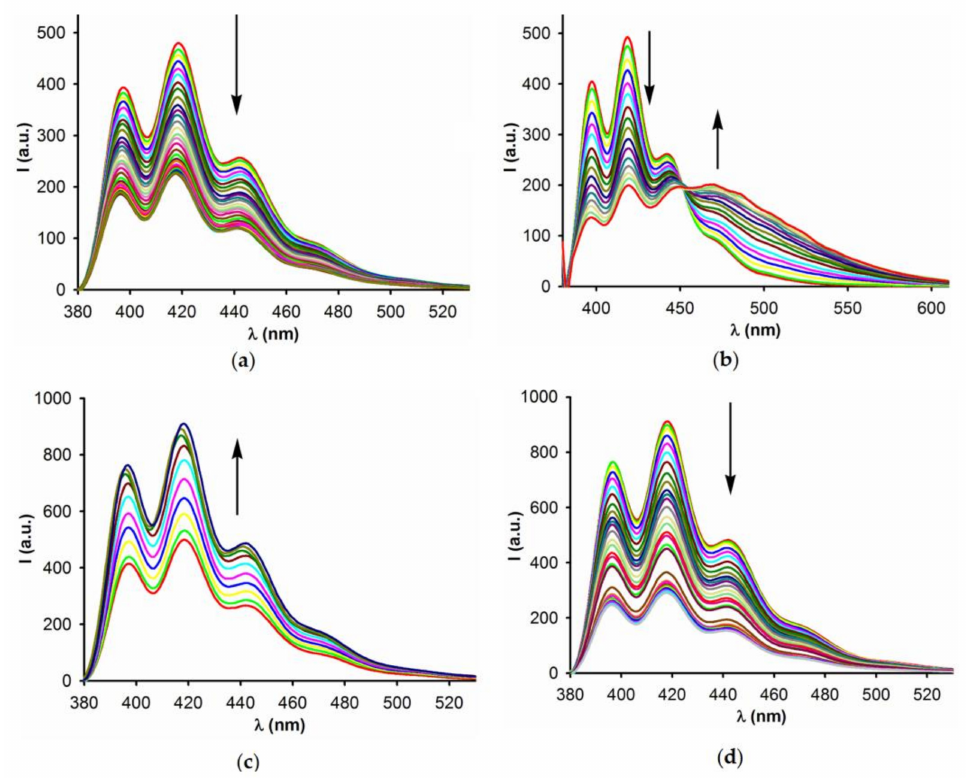
Figure 3. Changes in the fluorescence spectra of receptor 5 2+ · 2PF 6 − ( c = 1 × 10 − 5 M) in CH 3 CN upon addition of ( a )SO 42 − , ( b ) H 2 PO 4 − , ( c ) HP 2 O 73 − from 0 to 1.8 equiv., and ( d ) HP 2 O 73 − from 1.8 to 100 equiv. Arrows indicate the emission bands that increase or decrease during the